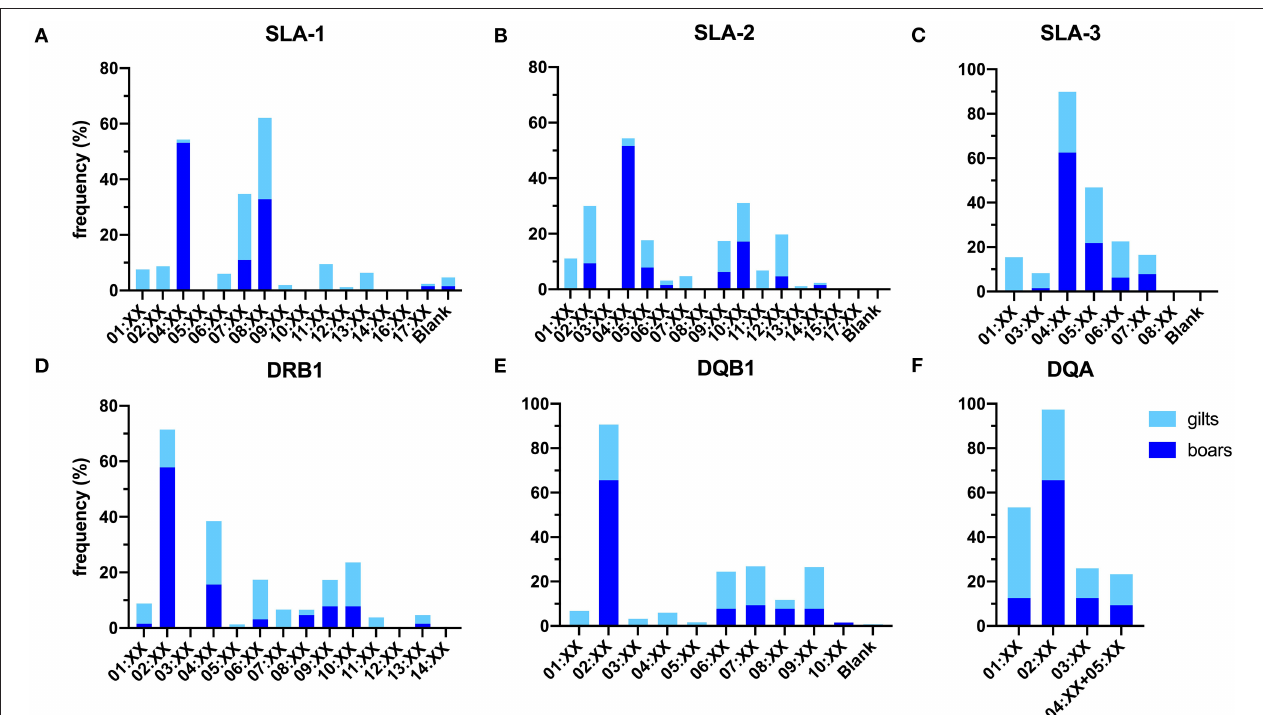
FIGURE 1 | Frequencies of SLA class I (A–C) and class II (D–F) allelic groups identified in the study population. Blank indicates alleles that cannot be detected with the primer sets utilized in the current study.